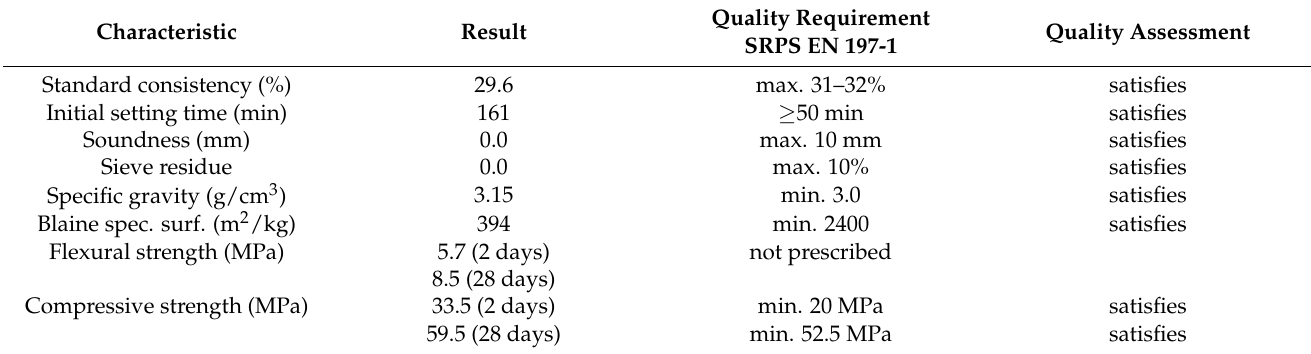
Table 1. Physico-mechanical characteristics of cement CEM I 52.5R, “CRH” Novi Popovac, Serbia.